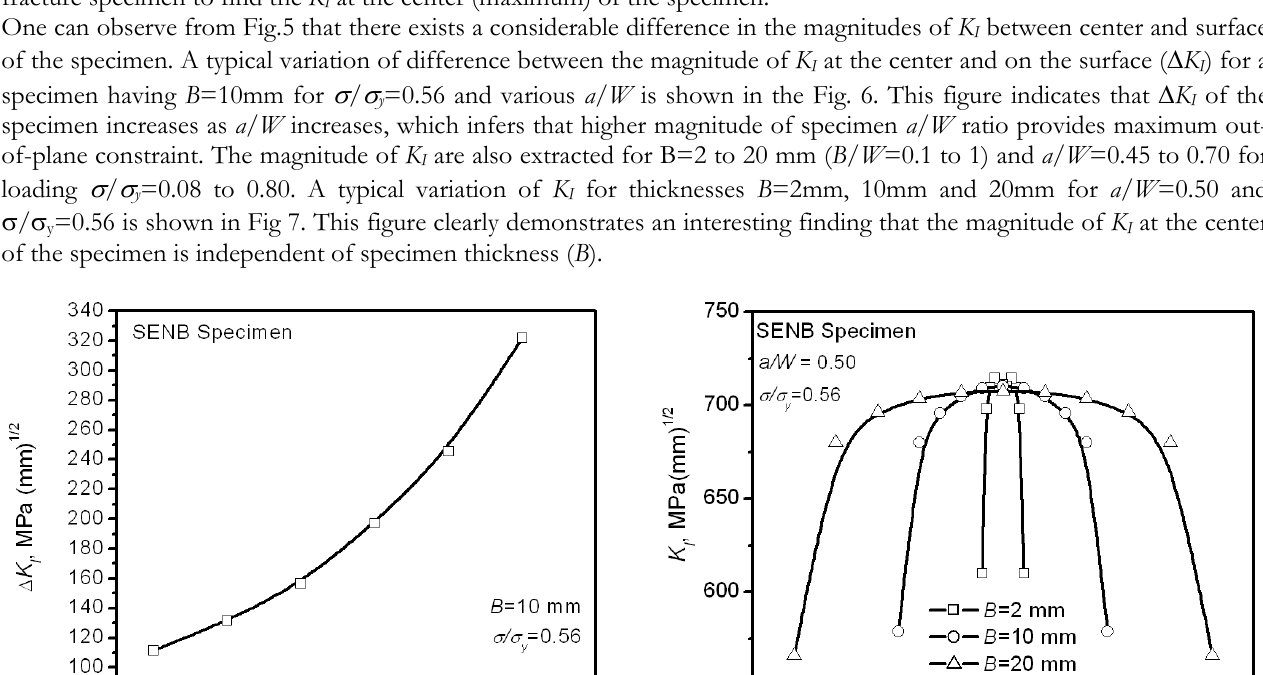
Figure 4: Variation of K loading.